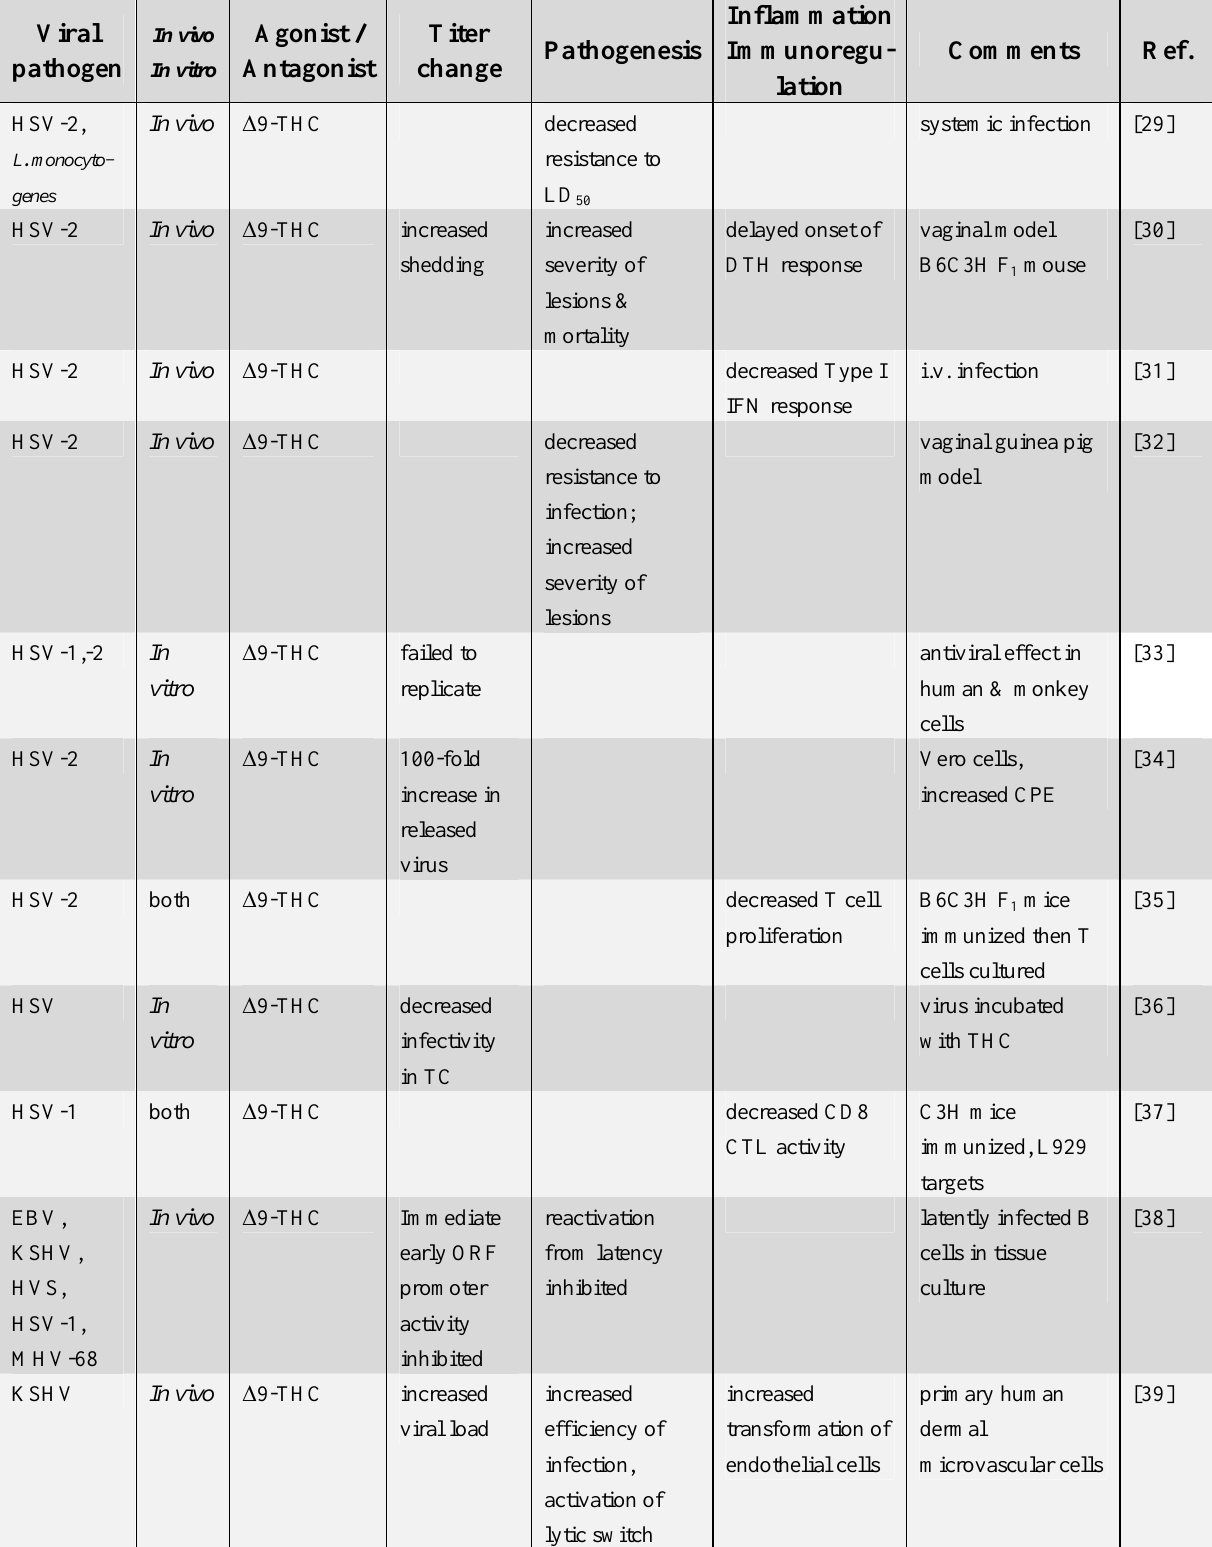
Table 2. Cannabinoids and Viral Infections.